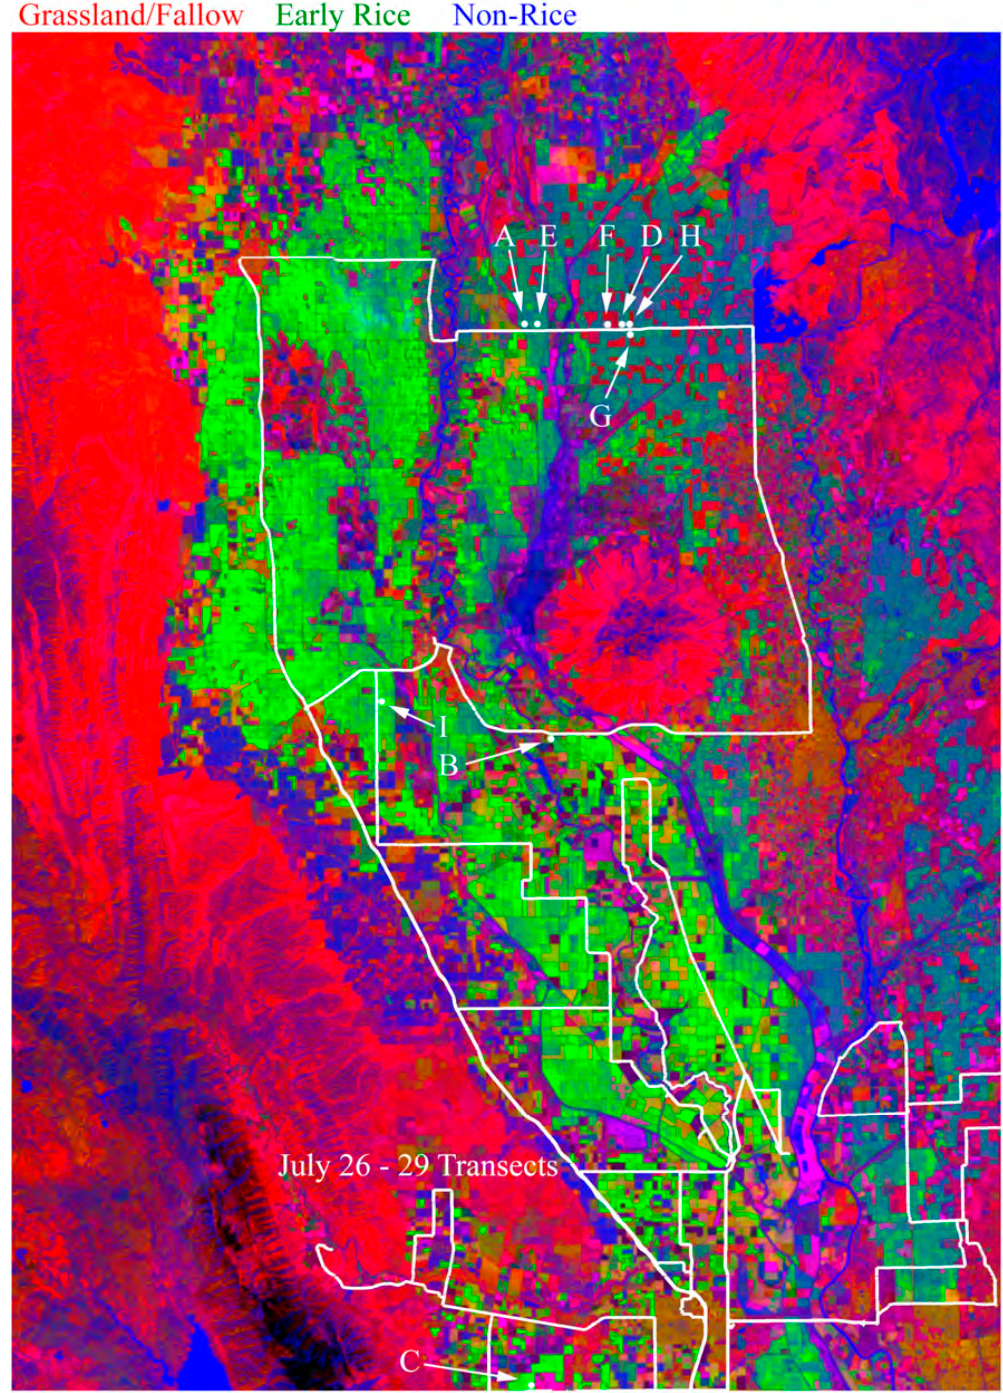
Figure 8. Mid-season TMM for 2018. Despite only 4 images from the first half of the 2018 season, the LST-based TMM discriminates rice from non-rice, as well as between early (bright green) and late (dark green) rice crops. Field validation was conducted July 25 - 29, 2018 using over 1650 km of driving transects, 8500 field photos, and 380 reflectance spectra. False negatives (rice mapped by the model as non-rice) are rare (< 1%), but false positives (non-rice mapped as rice) occur at a rate of 11%, generally in field that were fully green and/or heavily irrigated at the time when rice paddies are flooded. Labeled white circles (A-I) correspond to locations of field spectra in Appendix Figure A1.